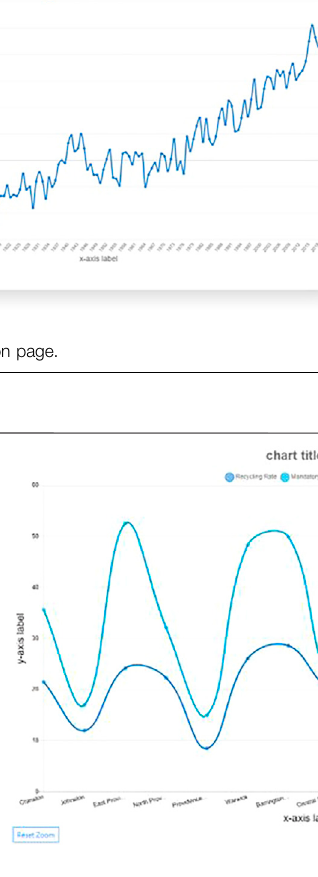
FIGURE 9 | simplechartsri.com created line graph of actual recycling rate of Rhode Island cities compared to the mandatory